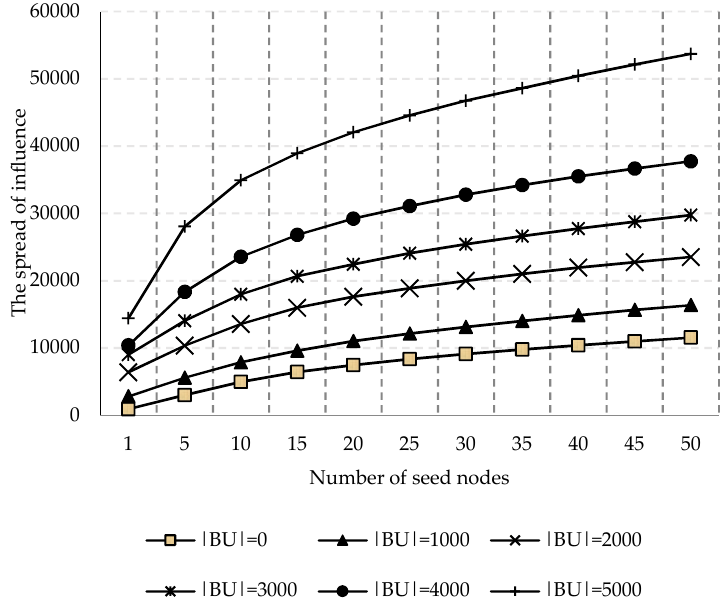
Figure 5. The information spread with a different number of Bridge Users in multi-social networks.